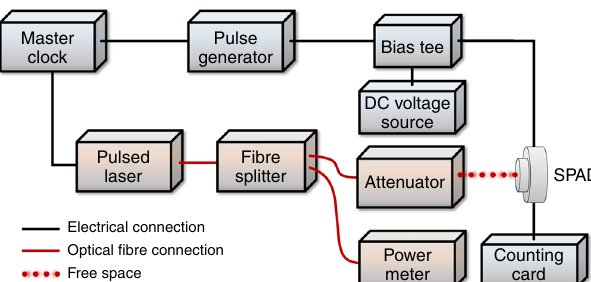
Fig. 7 Single-photon characterisation setup. Schematic diagram of the experimental setup used for time-correlated single-photon counting (TCSPC) characterisation. The black lines denote electrical connections, the red solid lines denote optical fi bre connections and the red dotted line denotes the free-space optical connection. The laser spot was directed onto the optical area of the SPAD using a broadband imaging system (not shown). The cryostat housing the SPAD has been removed for